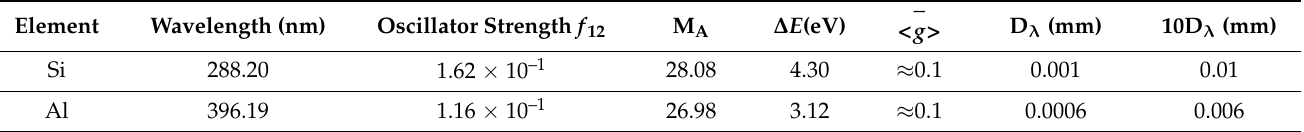
Figure 6. ( a ) Stark broadened line profile of Al-I line at 396.17 nm recorded for laser fluence of 37.6 J · cm − 2 ( b ) Electron number density as a function of laser fluence. Table 2. Spectroscopic parameters of the selected emission lines and calculated values of D λ for the validation of local thermodynamic equilibrium (LTE)